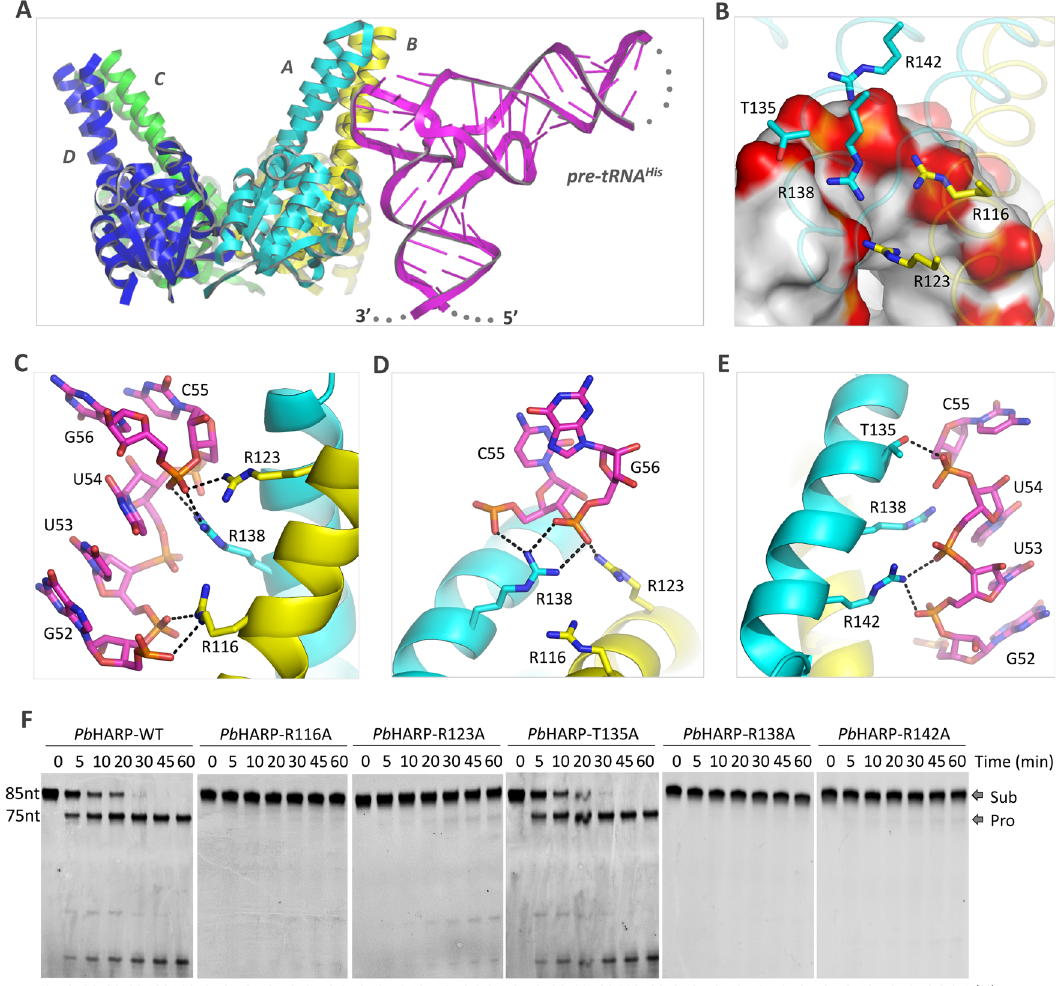
Fig. 2 The complex structure of Pb HARP/pre-tRNA His . A Cartoon presentation showing the overall fold and assembly of Pb HARP/pre-tRNA His complex. B The relative orientation between pre-tRNA His and the conserved Arg residues. Pre-tRNA His is shown as surface, the phosphate backbones are colored in red. C – E The detailed interactions between pre-tRNA His T ψ C-loop and Pb HARP AB dimer. Pre-tRNA His and all the interacting Arg and Thr residues are shown as sticks. The C-atoms of pre-tRNA His , the A and B monomers of Pb HARP are colored in magenta, yellow, and cyan, respectively. F In vitro pre- tRNA His cleavage assays catalyzed by wild-type and mutated Pb HARP. The protein and substrate concentrations are all fi xed at 1 μ M. The substrate cleavage percentage (%) is shown at the bottom of the gels. Experiments were repeated independently three times with similar results. Source data are provided in Source Data fi (Fig. 2D). R142 forms two H-bonds: one with the OP1 atom of U53 and the other with the OP2 atom of U54 (Fig. 2E).